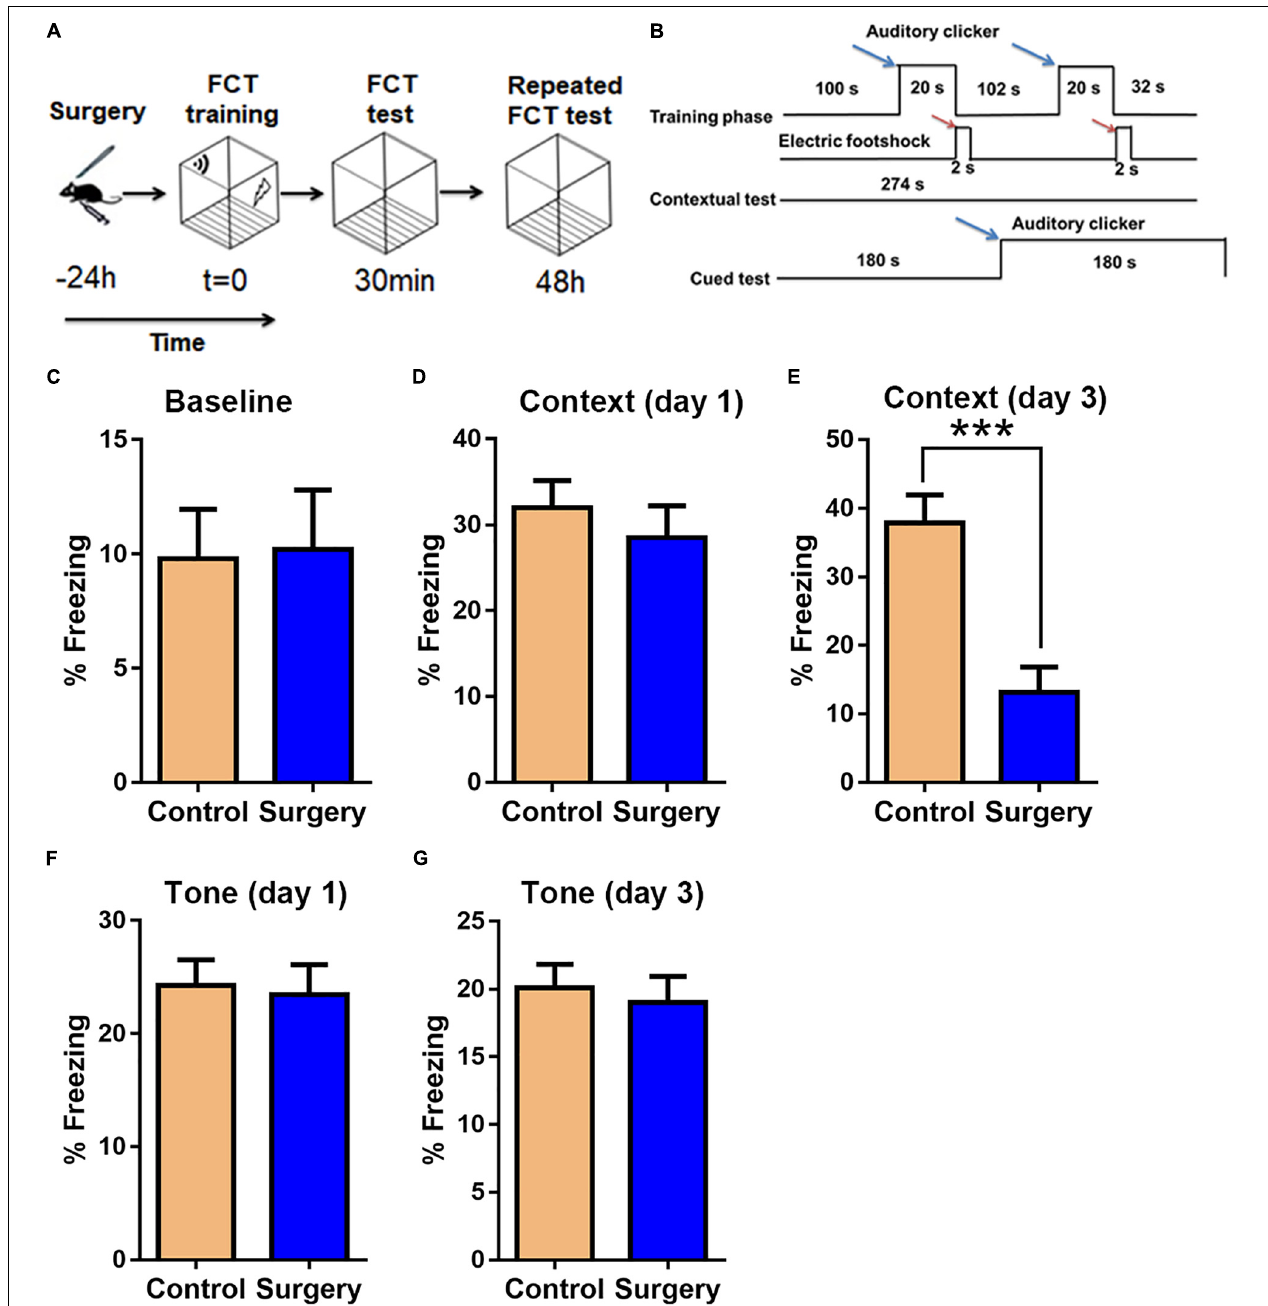
FIGURE 2 | Unilateral nephrectomy impairs associative cognitive function on day 3 post-surgery. (A) Fear conditioning test (FCT) design. (B) FCT workflow. Blue arrows indicate sound stimuli and red arrows indicate electric shock stimuli. (C) Baseline freezing levels. (D,E) Freezing levels in the contextual test on day 1 and day 3 post-surgery. (F,G) Freezing levels in the cued tone test on day 1 and day 3 post-surgery. Data are presented as means ± SEM; ∗∗∗ P < 0.001, vs. Control, Student’s t -test, N = 12 for all analyses.